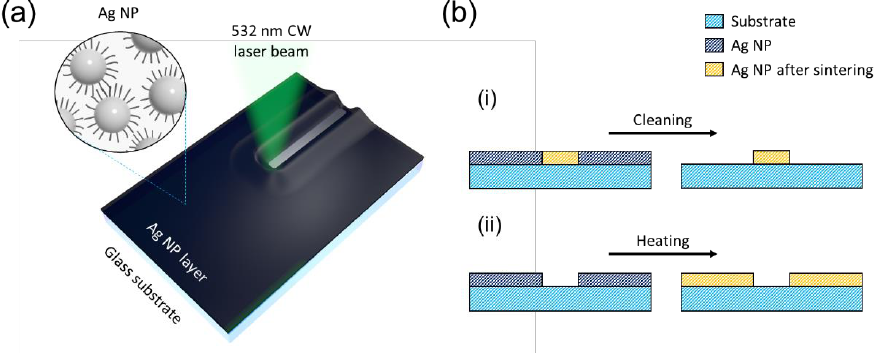
Figure 1. ( a ) Schematics of the proposed laser micropatterning for Ag NP ink; ( b ) The process flow of (i) the previous studies on SLS process for Ag NP ink and (ii) the proposed method.